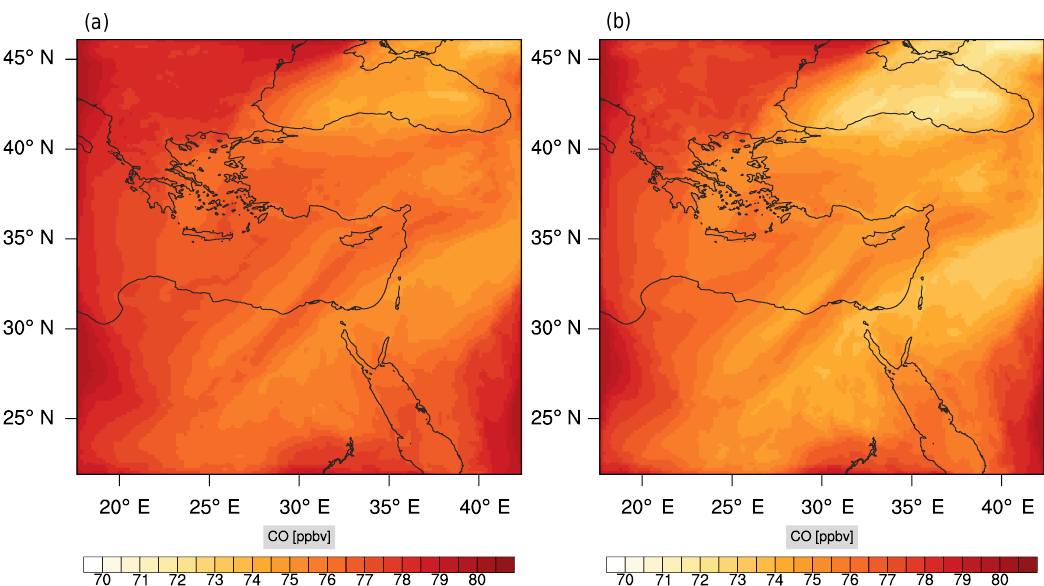
Figure 15. Instantaneous comparison of the carbon monoxide spatial mixing ratio, averaged over the vertical layers 10–22, using the full mechanism (a) and skeletal mechanism (b) .